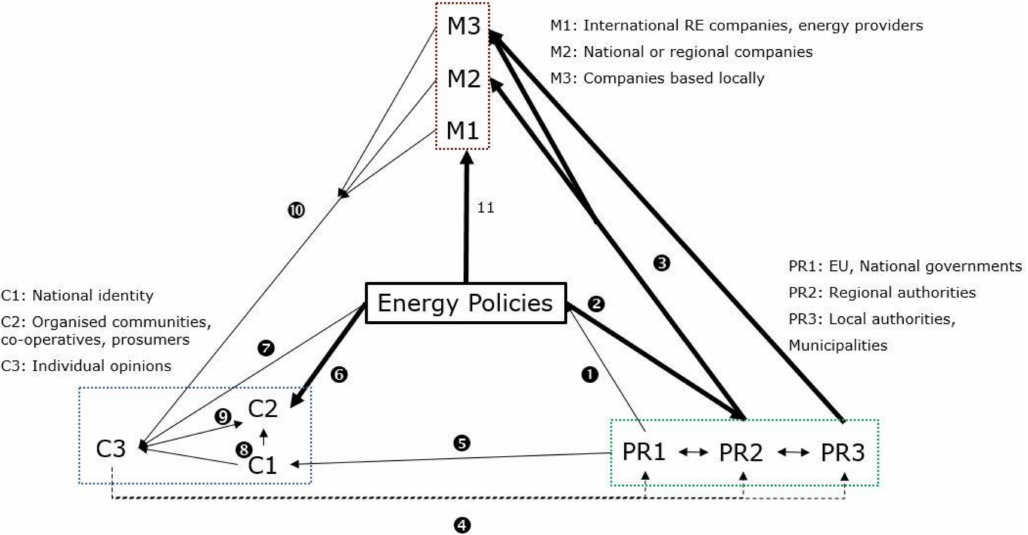
Figure 8. Analytical framework: representation of dimensions and scales of social acceptance with extended representation of dynamics between dimensions and scales—bold arrows represent interactions generally addressed by NREAP